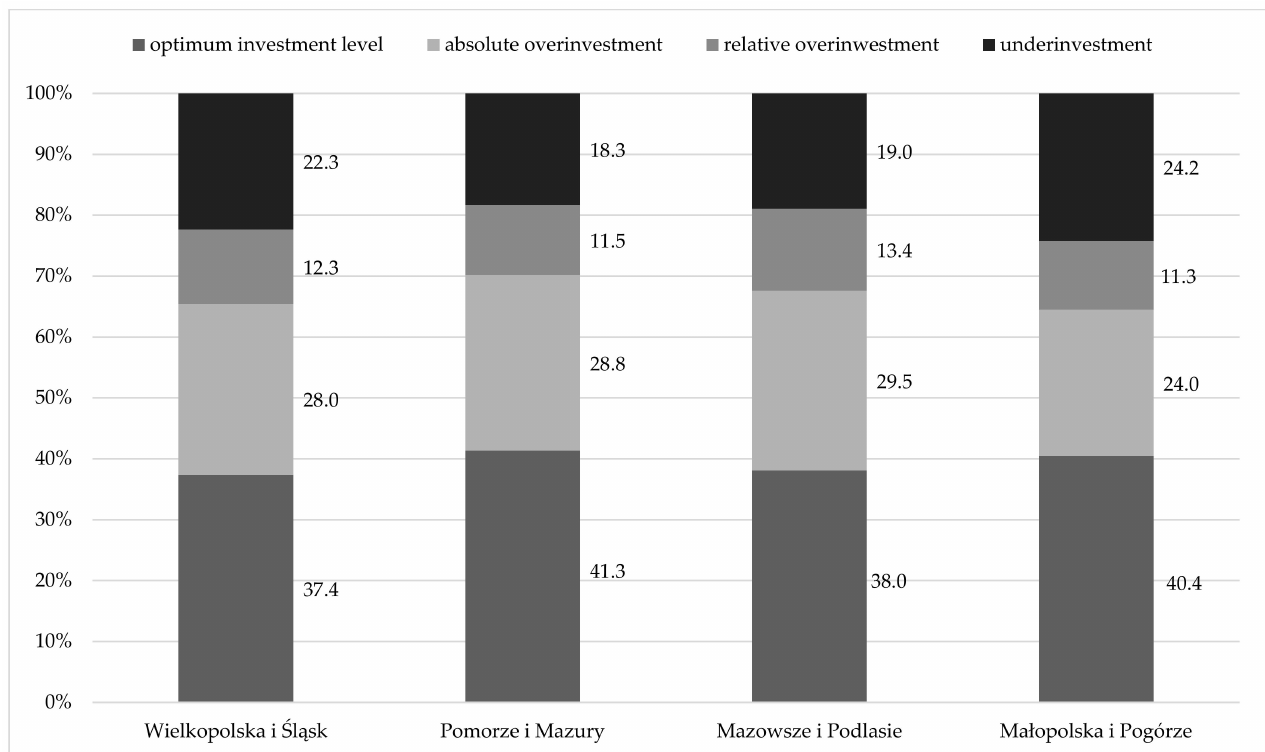
Figure 3. Farm structure according to overinvestment groups in Polish regions. Source: own elaboration based on EU-FADN–DG